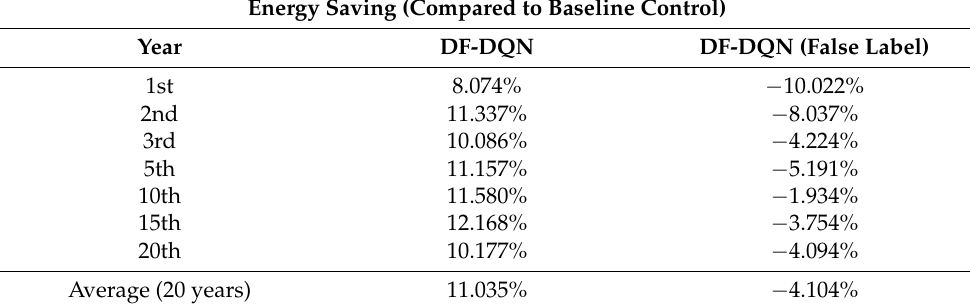
Figure 12. Comparison of cumulative power between DF-DQN and DF-DQN (false label).